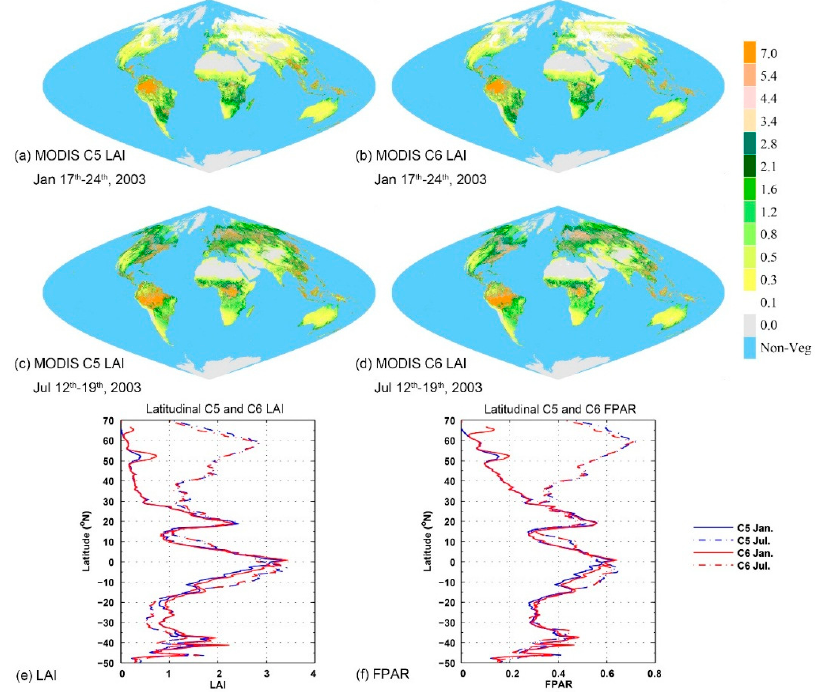
Figure 2. Global distribution of LAI/FPAR from January (17–24 January) and July (12–19 July) of 2003. Panel ( a )–( d ) are color-coded maps of MODIS C6 and C5 LAI. Figure S2 shows FPAR. Area-equal sinusoidal projection is used here; panels ( e ) and ( f ) show the latitudinal distribution of global LAI and FPAR, respectively. The latitude interval is 0.1°. In these plots, MODIS C6 and C5 use red and blue lines, respectively. Solid and dashed lines depict January and July, respectively.